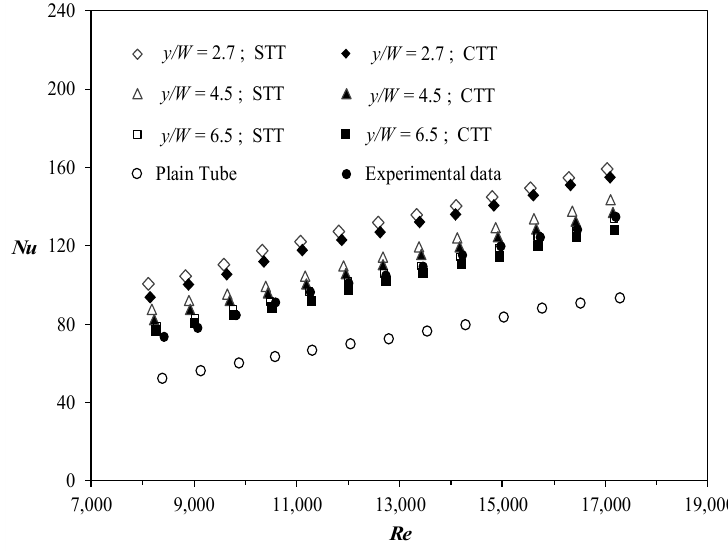
Figure 4. Nu for various CTTs and STTs.